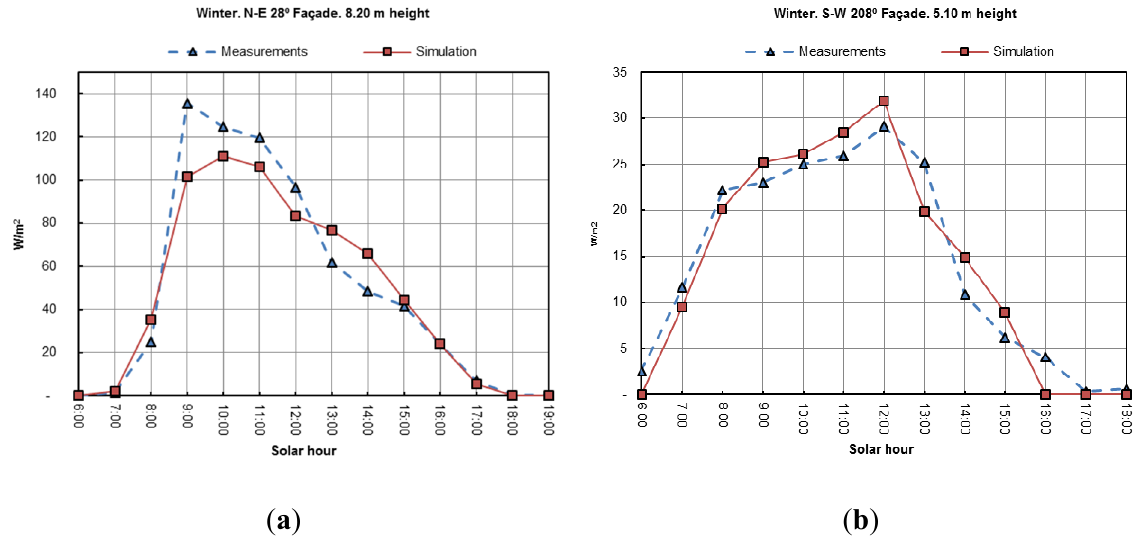
Figure 7. 24 h comparison between cell measurements and simulations, winter in Cadiz. ( a ) N-E 28º Façade. ( b ) S-W 208º Façade.